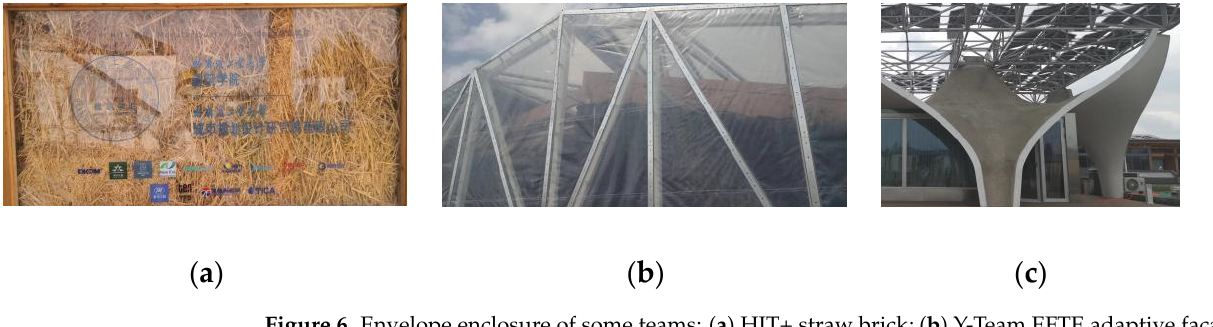
Figure 6. Envelope enclosure of some teams: ( a ) HIT+ straw brick; ( b ) Y-Team EFTE adaptive façade; and ( c ) Solar Ark self-developed UHPC concrete.